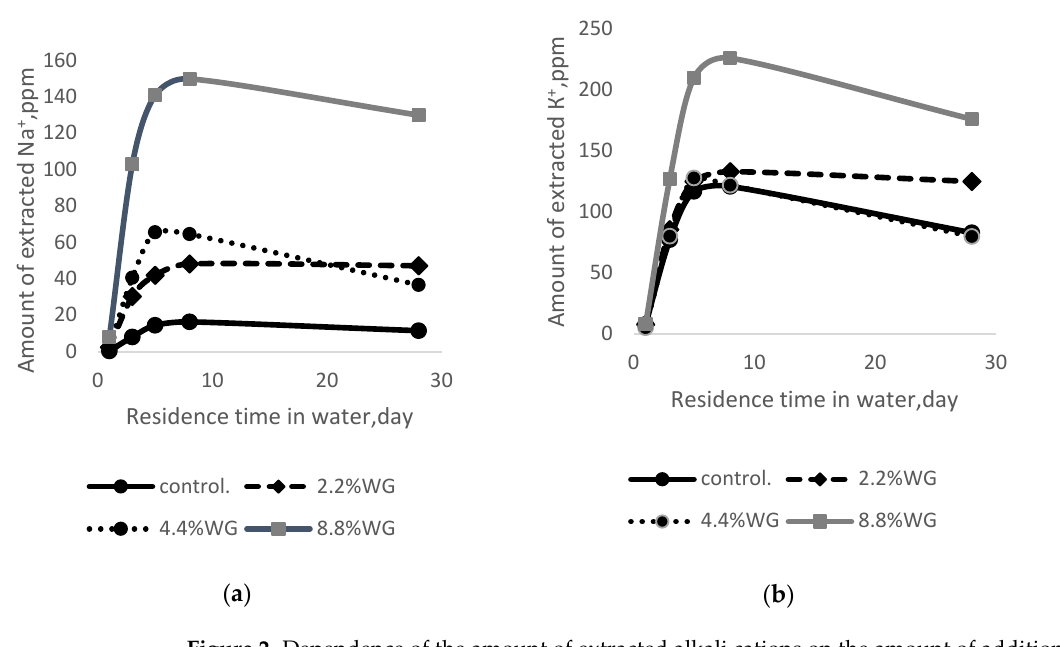
Figure 2. Dependence of the amount of extracted alkali cations on the amount of addition of sodium WG and residence time in the water: ( a ) Na + ; ( b ) K + .